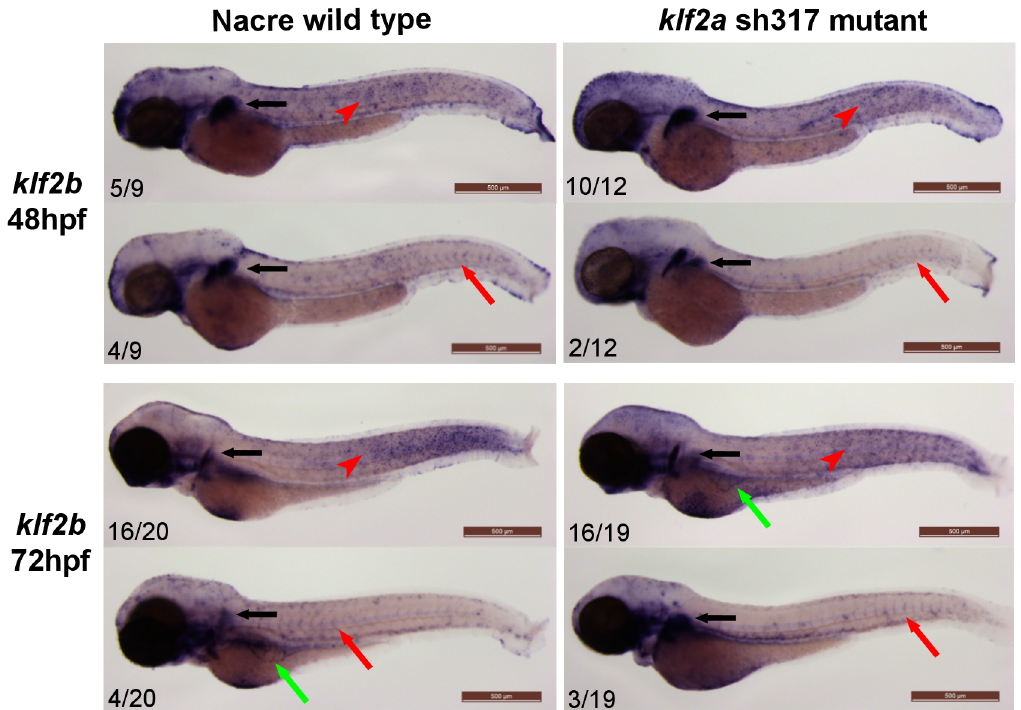
Fig 8. klf2b expression patterns do not differ between wildtype and klf2a sh317 mutants. klf2b mRNA is detectable in the developing pectoral fin bud (black arrows). Most of the embryos examined exhibit klf2b mRNA presence on the surface of the embryos representing epidermal cells as described before [17, 48] (red arrowheads). A small proportion of both wildtype and klf2a sh317 mutant embryos show vascular staining in the ISVs (red arrows) and/or in the subintestinal veins (green arrows). There were no differences in staining patterns and especially in the level of vascular staining observed between wildtype and klf2a sh317 mutant embryos. Figures in bottom left corner of each image indicate the number of embryos with similar staining patterns out of total number of embryos examined. Scale bar = 500 μ m.